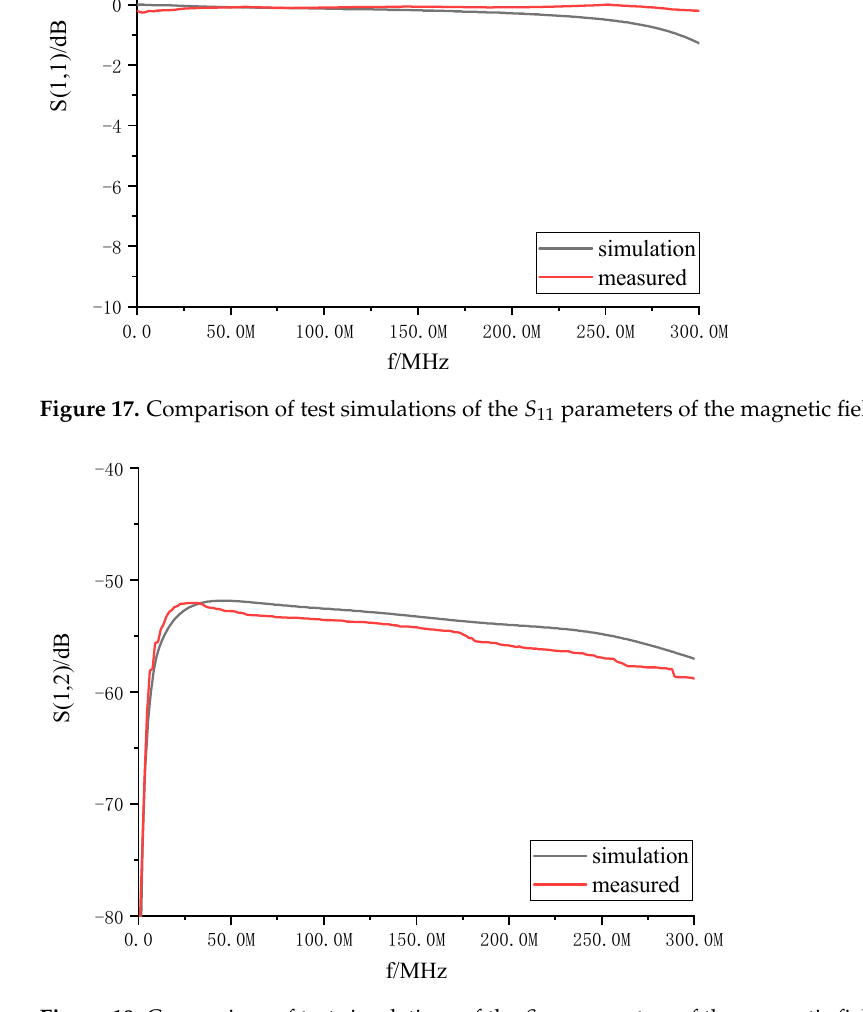
Figure 18. Comparison of test simulations of the 12 S parameters of the magnetic field probe.